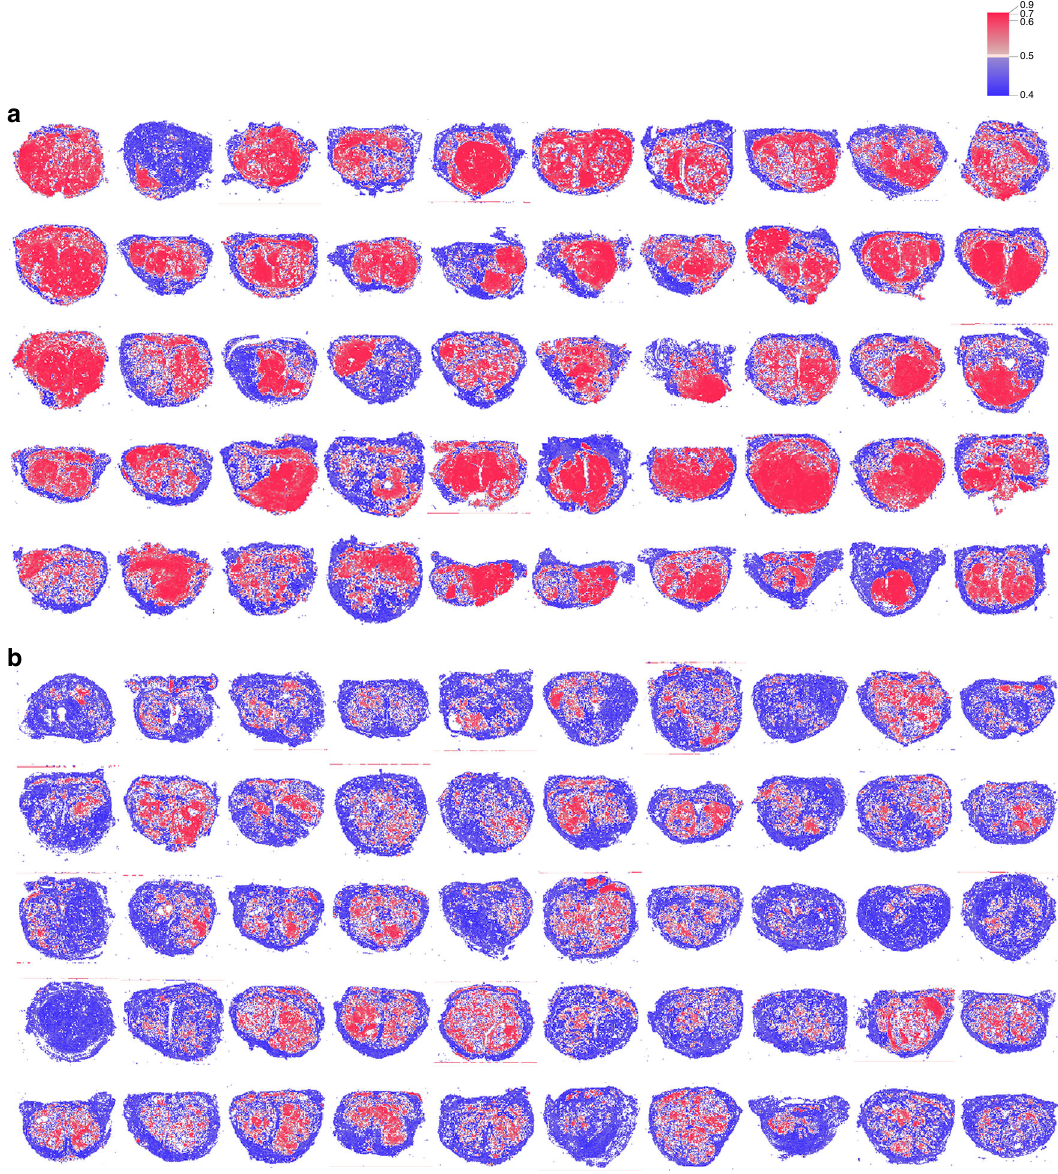
Fig. 2 Examples of compressed images. Whole-mount pathology images with 10-billion-scale pixel data were reduced to only 100 feature data, while retaining core image information. a Images of biochemical recurrence (BCR) cases, b images of no BCR cases. The color of each region indicates positive (red) and negative (blue) for characteristics detected.